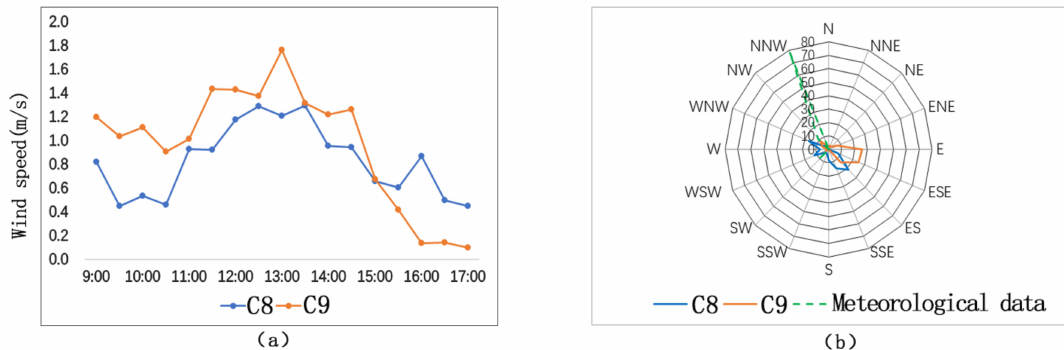
Figure 13. Comparison of wind speeds and wind direction frequencies on street-entry-type streets: ( a ) wind speeds; ( b ) wind direction